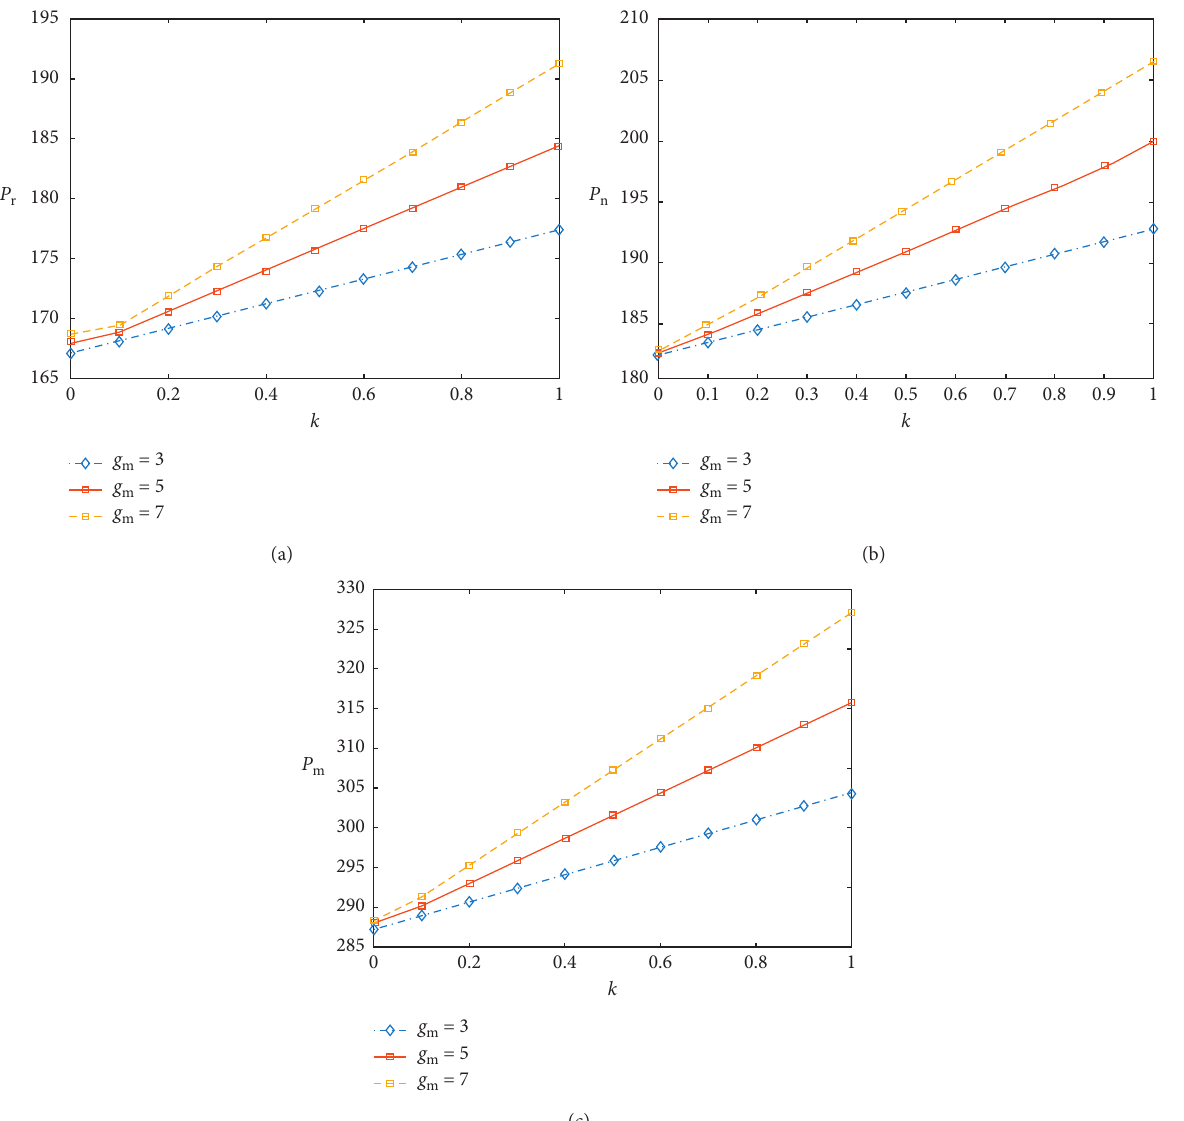
Figure 2: Impact of consumers’ green recycling consciousness k and power battery greenness g influence of consumers’ green recycling consciousness k on recycling price p k on recycling price p ; (c) the influence of consumers’ green recycling consciousness k on recycling price p n